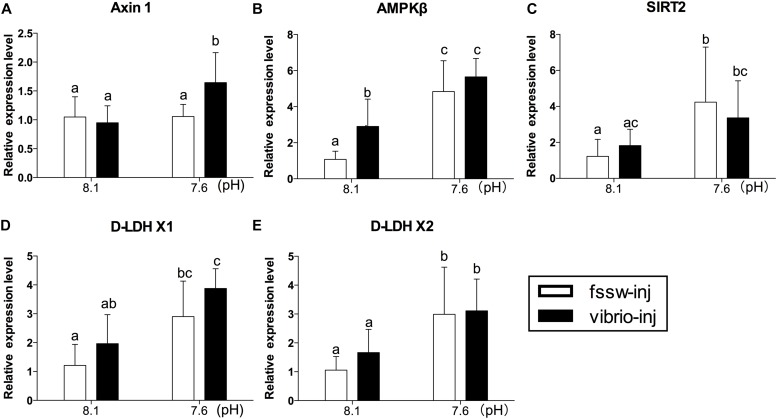
The mRNA expression profiles of anaerobic energy metabolism- and energy sensing-related genes in the digestive glands of oysters post elevated pCO2 and V. splendidus exposure. (A) Axin1. (B) AMPKβ. (C) SIRT2. (D)
D-LDH X1. (E)
D-LDH X2. Each bar represents mean ± SD (n = 6). Different letters indicate significant differences among treatments (p < 0.05), and identical letters indicate no significant difference.